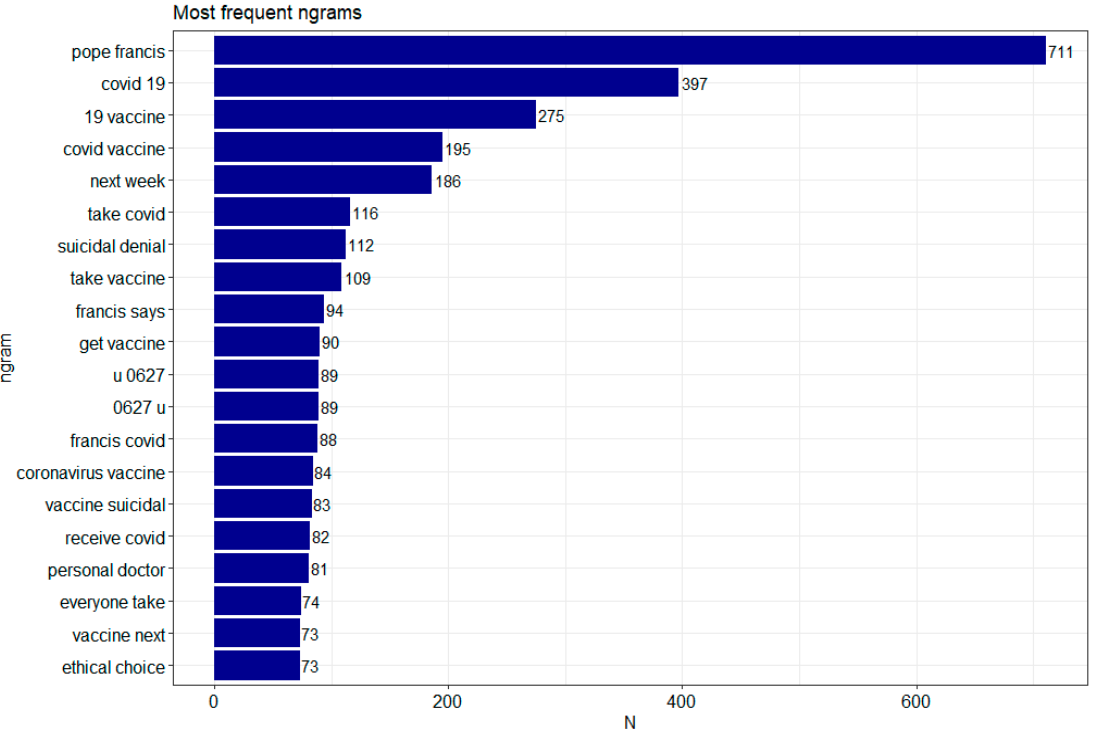
Figure 4. The most common bigrams. Made using ggplot2, tm and tidytext libraries in R.